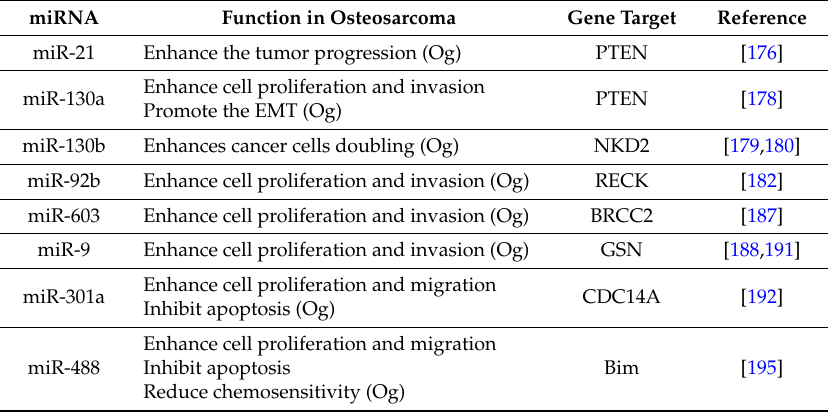
Table 3. Latest discovered cancer-related oncomiRs in